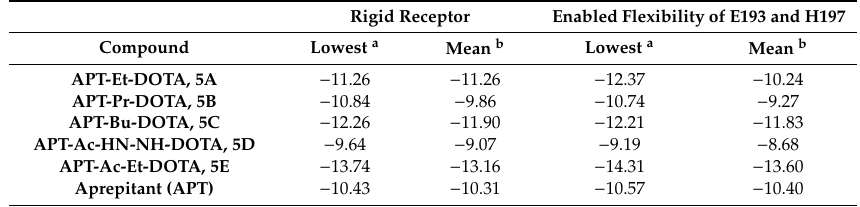
(kcal / mol). Rigid Receptor Enabled Flexibility of E193 and H197 Compound Lowest a Mean b Lowest a Mean b APT-Et-DOTA,